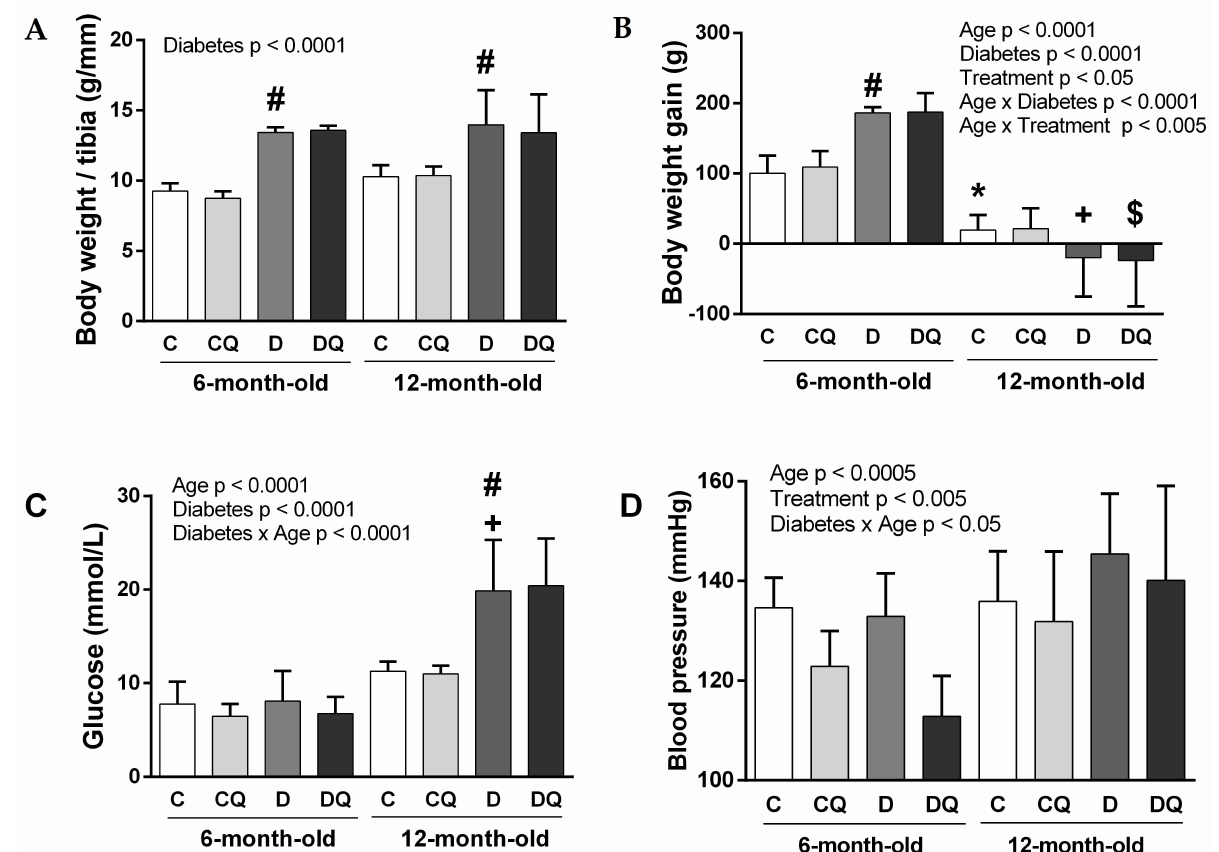
Figure 1. Basic characteristics of experimental animals: body weight/tibia ratio ( A ), body weight gain ( B ), blood glucose concentration ( C ), systolic blood pressure ( D ). Abbreviations: C—lean control vehicle-treated, CQ—lean control quercetin- treated, D—Zucker diabetic fatty (ZDF) vehicle-treated, DQ—ZDF quercetin-treated. * p < 0.05 versus 6-month-old C group, + p < 0.05 versus 6-month-old D group, # p < 0.05 versus age-matched C group, $ p < 0.05 versus age-matched D group. Data are presented as means ± standard